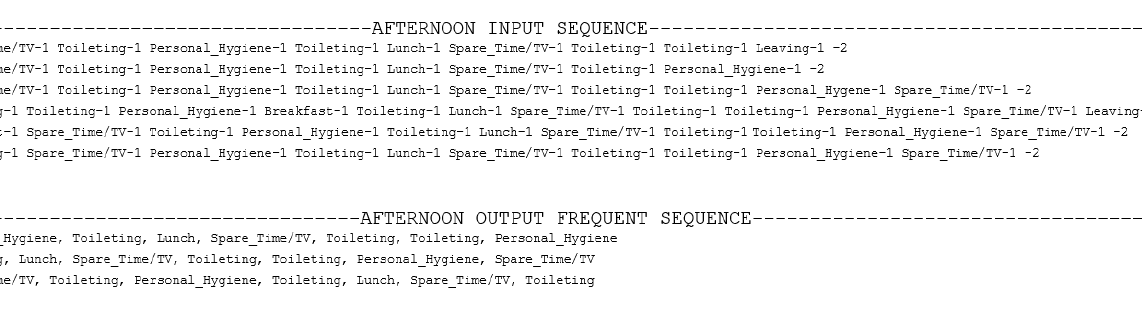
Figure 8. Frequent patterns (most frequent sequences of activities) for the afternoon identified by the Gab-BIDE algorithm.